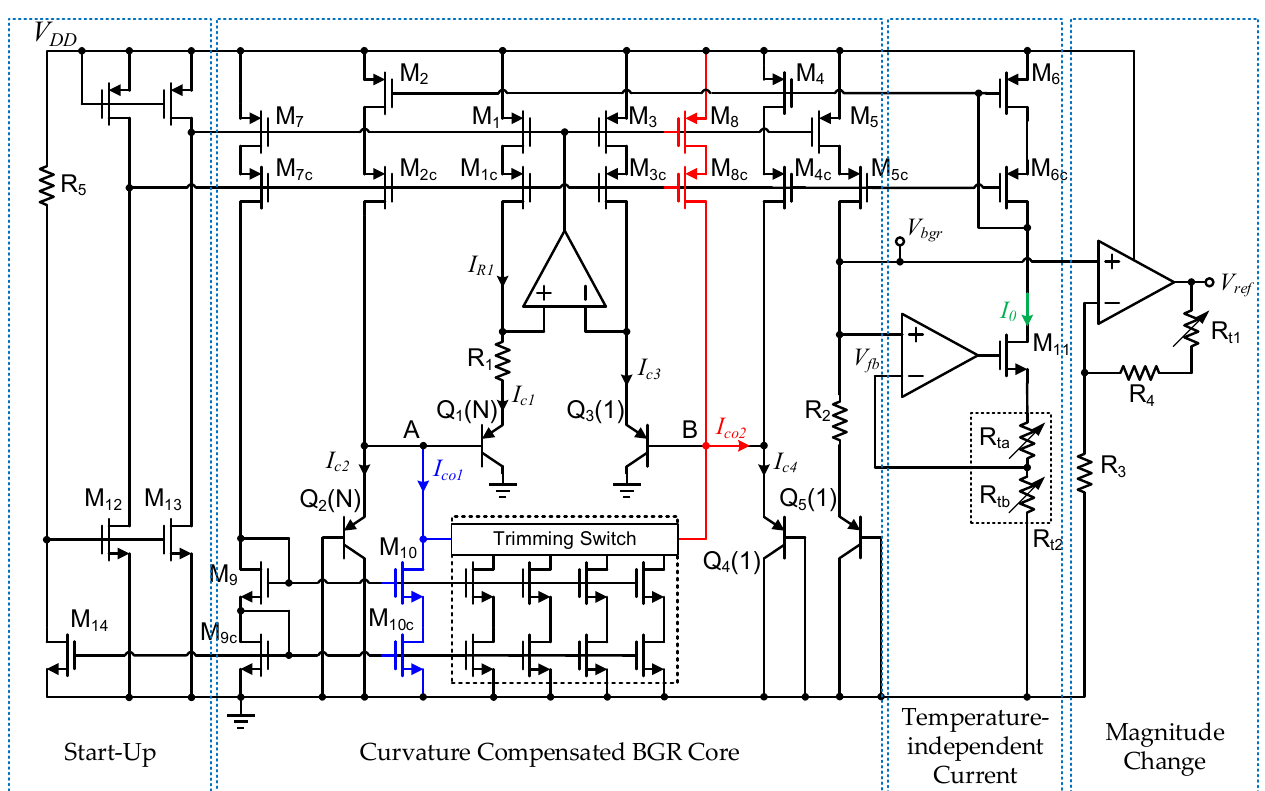
Figure 6. Schematic of the proposed curvature-compensated BGR circuit.